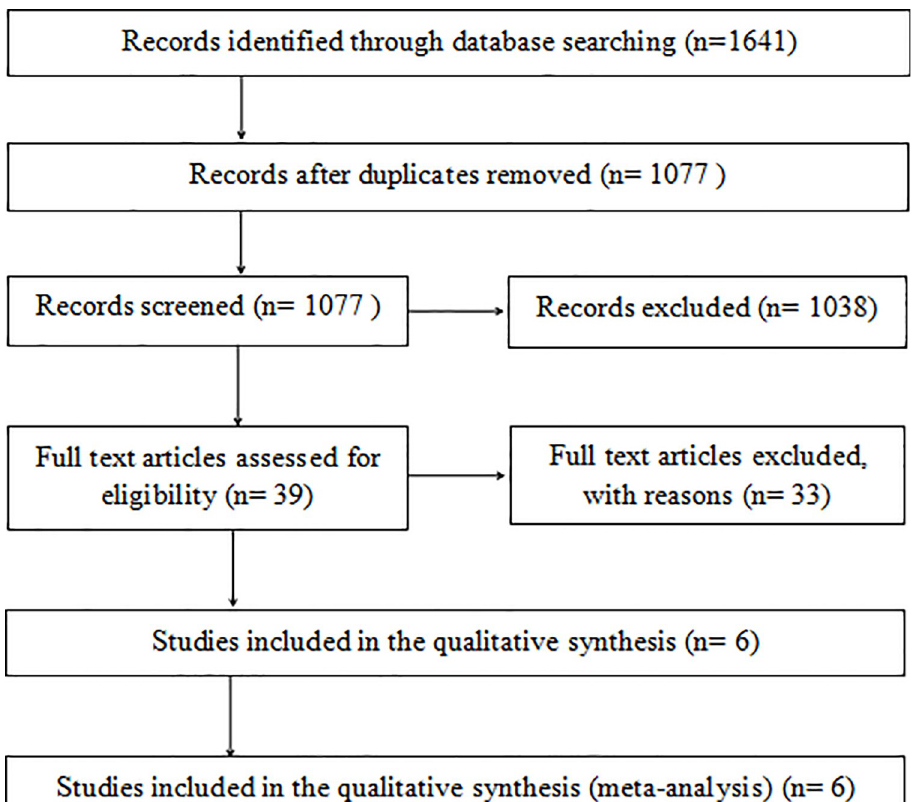
Fig 1. The flow chart of systematic review based on PRISMA